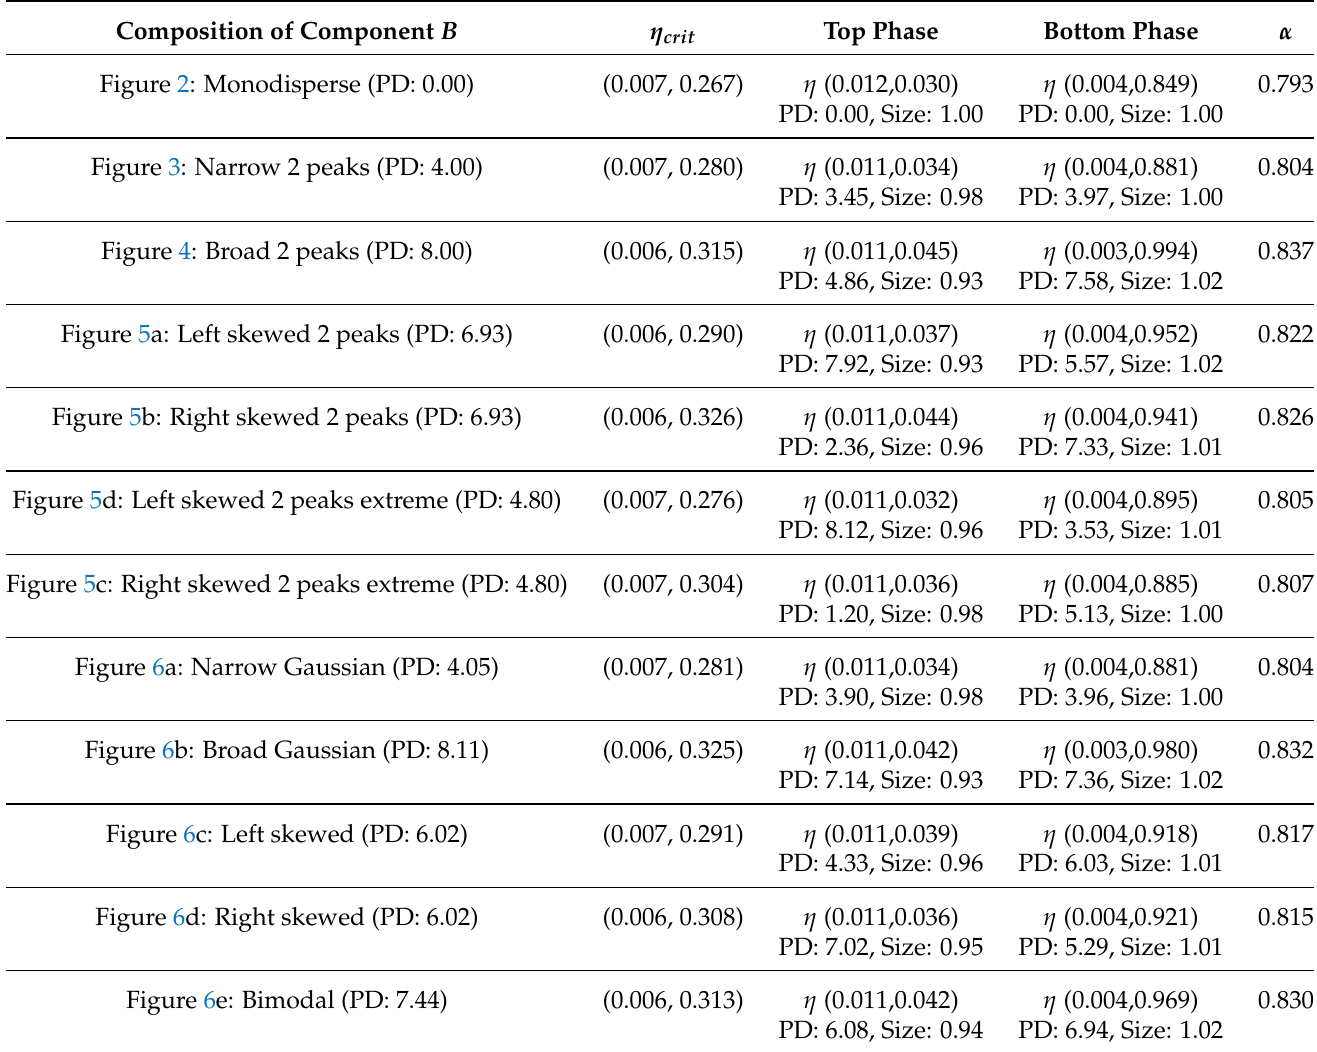
Table 1. Critical points for the different binary mixtures depending on the distribution of component B , see also Figures 2–6 and phase-separated concentrations and volume fraction α of the different mixtures for specific parent concen- = 0.010, η = 0.200), depending on the distribution of component B ; see Table 2 for the distribution of tration ( η A B parent parent component B in each phase.